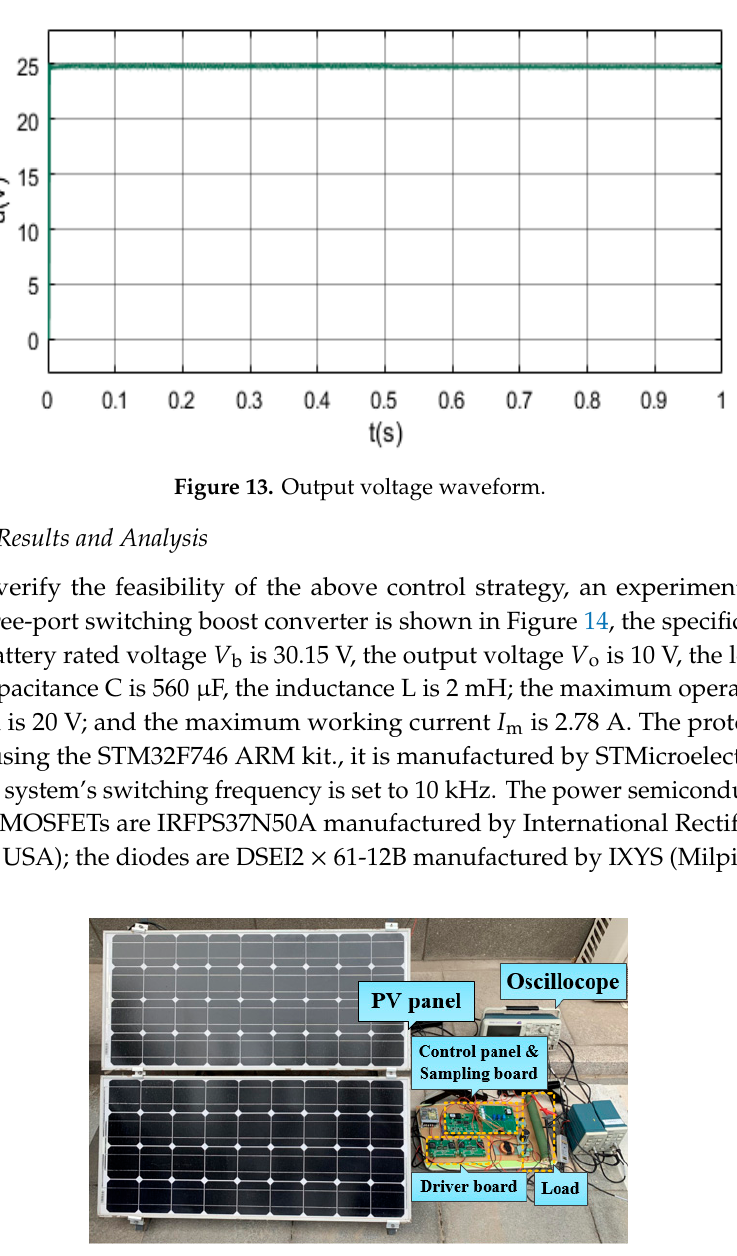
Figure 14. The experimental platform.